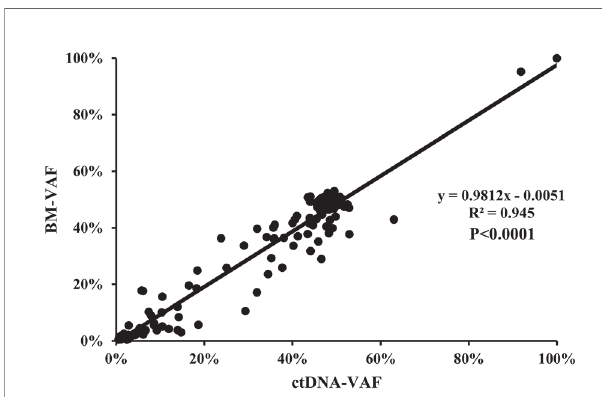
FIGURE 4 | The correlation of the variant allelic frequencies (VAFs) in the same mutation site detected in BM and ctDNA among the 164 individual mutations detected by both assays.